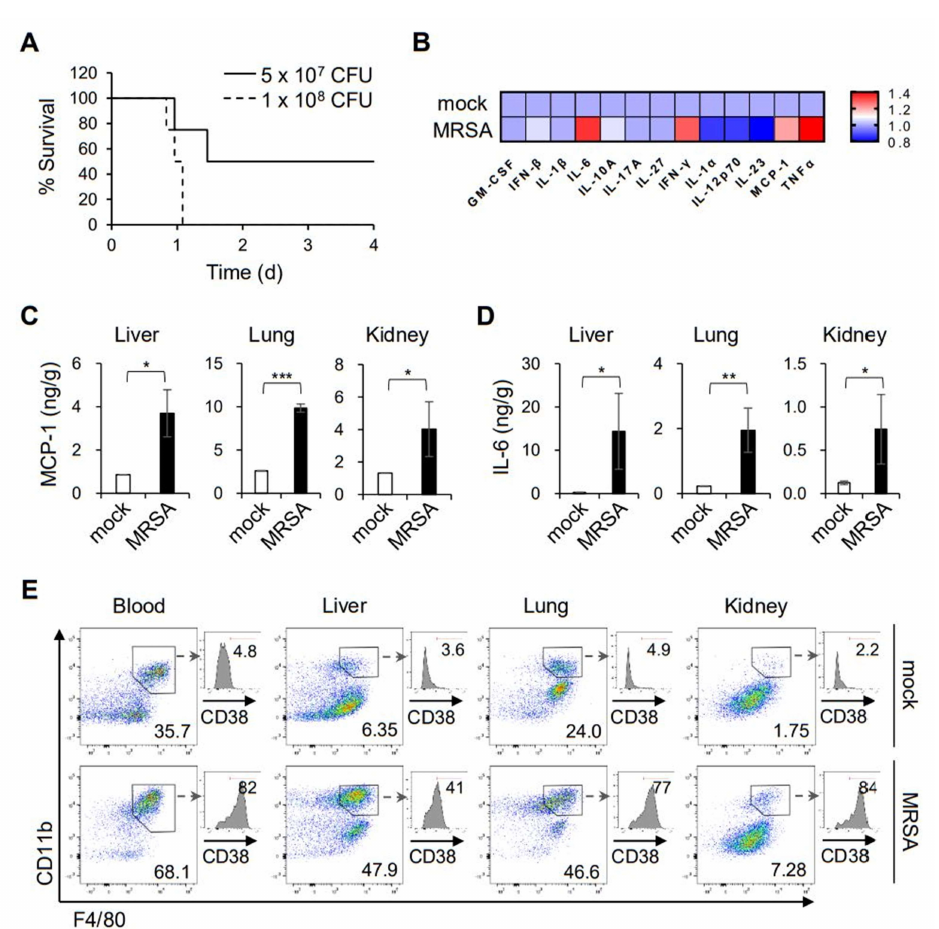
Figure 1. Infiltration and activation of pro-inflammatory macrophages upon MRSA infection. ( A ) Mice were infected intravenously with two different doses of MRSA, and mortality was monitored; n = 4. ( B ) Cytokines and chemokines in the plasma were measured by CBA 8 h after infection with 5 × 10 7 CFU MRSA. The relative amounts of cytokines are presented as a heat map. ( C and D ) Tissue lysates of the liver, lung and kidney were prepared 8 h after infection, and the cytokine levels were determined by CBA. The mean ( ± S.D.) amounts of MCP-1 ( C ) and IL-6 ( D ) are shown; * p < 0.05, ** p < 0.01, *** p < 0.001. ( E ) Single cell suspension of the tissue homogenates was stained for flow cytometry, and the representative FACS profiles are shown with the frequency of the CD11b + F4/80 + populations in the viable CD45.2 + gates; n = 3. CD11b + F4/80 + macrophages were further analyzed for surface expression of CD38 and shown as histograms with the frequency of CD38 +